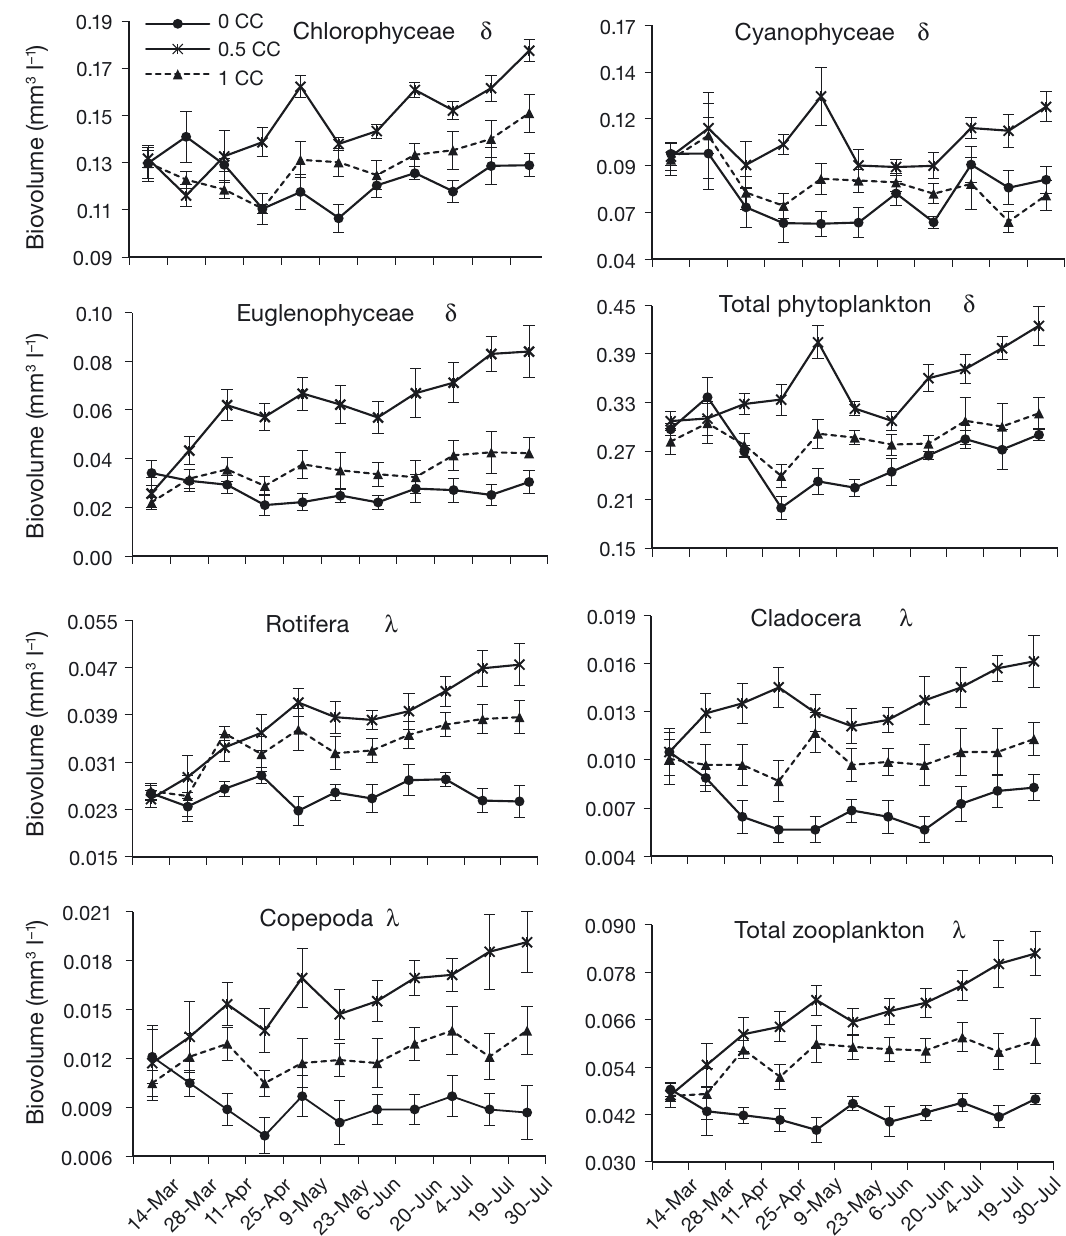
Fig. 2. Interaction between time and common carp (CC; Cyprinus carpio) density on the changes in different groups of plank- ton biovolumes in the pond sediment. Data are means (±SE). 0 CC, 0.5 CC and 1 CC indicate the ponds without common carp, with 0.5 common carp m −2 , and with 1 common carp m −2 , respectively. δ indicates that the ponds with 0.5 common carp m −2 are significantly different (p < 0.05) from the ponds with 1 common carp m −2 , and the ponds without common carp. λ indicates that the ponds without common carp, with 0.5 common carp m −2 , and with 1 common carp m −2 are significantly different from each other (p <